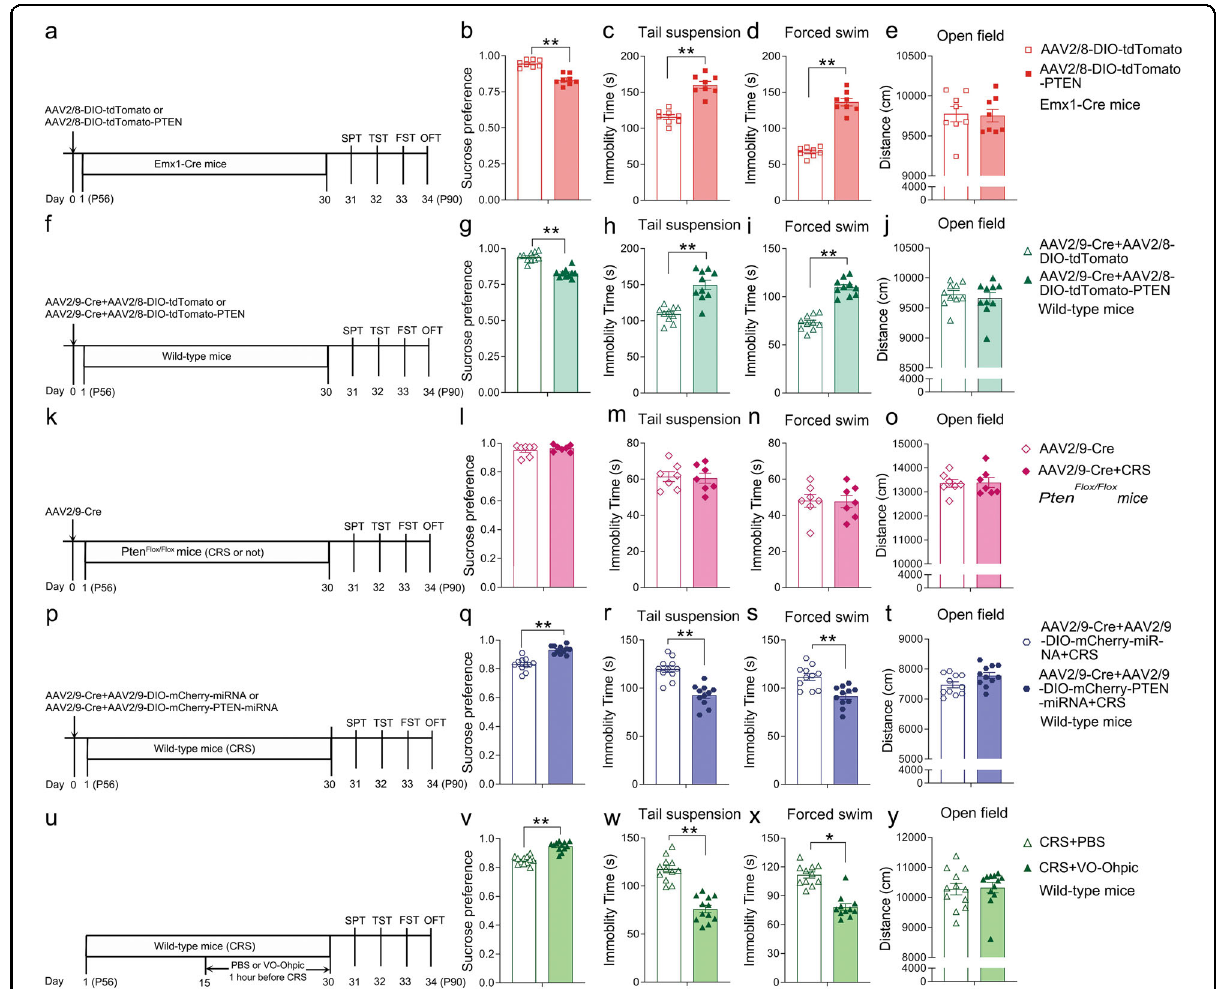
Fig. 3 PTEN in the PFC is essential in the regulation of depression-like behaviors in mice. a Diagram of experiment design and timeline for ( b – e ). b – e Compared with control mice, the mice with over-expression of PTEN in the PFC showed decreased sucrose preference ( b ), increased immobility time in the TST ( c ), and FST ( d ), no changes in the total traveled distance in OFT ( e ). Cre-dependent over-expression of Pten was achieved in Emx1-Cre mice. n = 8 in each group. f Diagram of experiment design and timeline for ( g – j ). g – j Wild-type mice with over-expression of PTEN in the PFC showed decreased sucrose preference ( g ) and increased immobility time in the TST ( h ) and FST ( i ) without obvious changes in the total traveled distance in the OFT ( j ). n = 10 in each group. k Diagram of experiment design and timeline for ( l – o ). l – o Genetic inactivation of Pten in the PFC of Pten Flox/Flox mice with one-month CRS showed no differences in the sucrose preference ( l ), immobility time in the TST ( m ), and FST ( n ), or total distance traveled in the OFT ( o ) compared with control Pten Flox/Flox mice raised in home cage. n = 7 in each group. p Diagram of experiment design and timeline for ( q – t ). q – s The decreased sucrose preferences ( q ) and increased immobility time in the TST ( r ), and FST ( s ) in one-month CRS-treated wild-type mice were signi fi cantly attenuated with knockdown of Pten in the PFC. t Knockdown of Pten did not affect the traveled distance shown by the OFT. n = 11 in each group. u Diagram of experiment design and timeline for ( v – y ). v – x The sucrose preference is improved ( v ), and the immobility time in TST ( w ), and FST ( x ) is reduced in CRS-treated mice by VO-Ohpic treatment. y The locomotor activity shown by OFT is not signi fi cantly changed in CRS-treated mice with the application of VO-Ohpic. n = 12 in each group. All data are presented as mean ± SEM. Student ’ s t - tests, * p < 0.05, ** p < 0.01. CRS, chronic restraint stress; FST, forced swim test; OFT, open- fi eld test; SPT, sucrose preference test; TST, tail suspension test; VO-Ohpic, VO-Ohpic